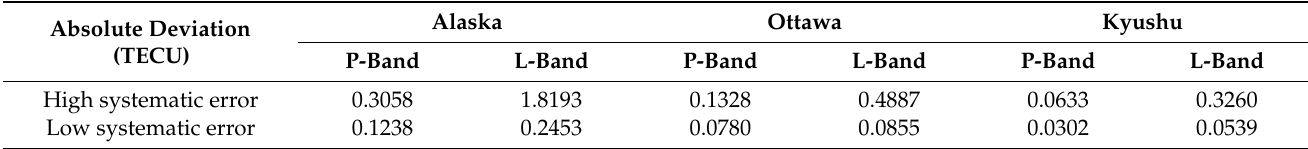
Figure 4. TEC retrieval in Kyushu based on L-band SAR ( a ) and P-band SAR ( c ) with high systematic error level. The deviations between the retrieval and the true values (Figure 1c) are shown in ( b , d ). Table 2. Evaluation results of Figures